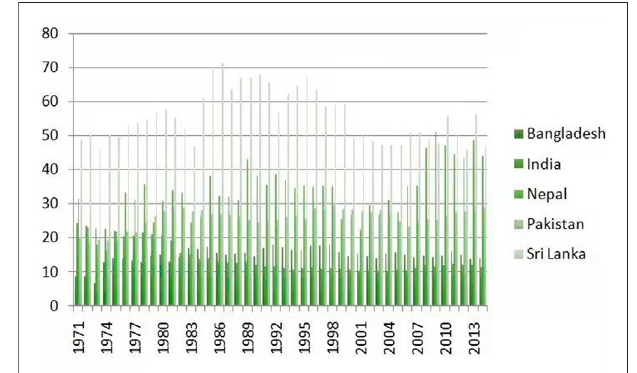
FIGURE 1 | CO 2 emission from